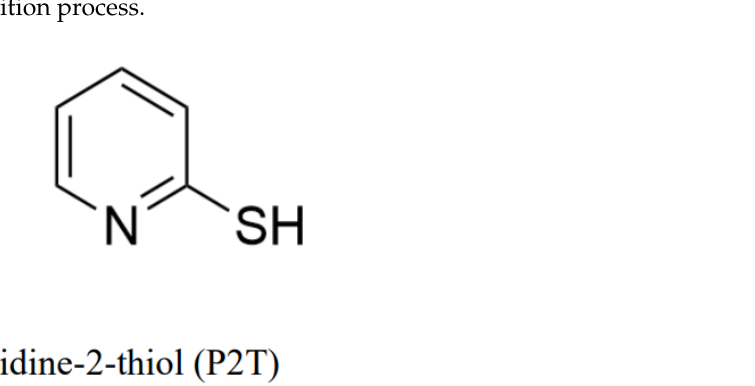
Figure 1. Molecular structure of pyridine-2-thiol (P2T), the inhibitor used for this study.